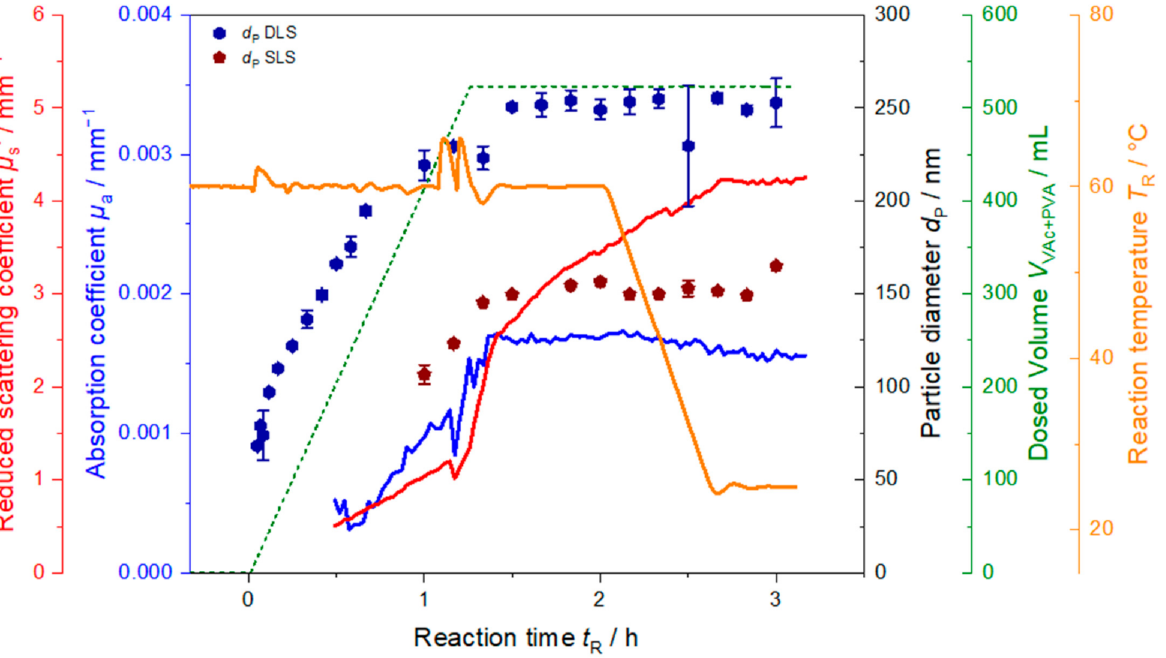
Figure 7. Reduced scattering coefficient µ s ’ (red), absorption coefficient µ a (blue) at λ = 637 nm, combined dosed mass of monomer and protective colloid (dashed green line) and reaction temperature (orange) as function of time during synthesis PVAc_1wr. The dosing of monomer and PVA had to be aborted due to gelation of the sample at t R = 1.1